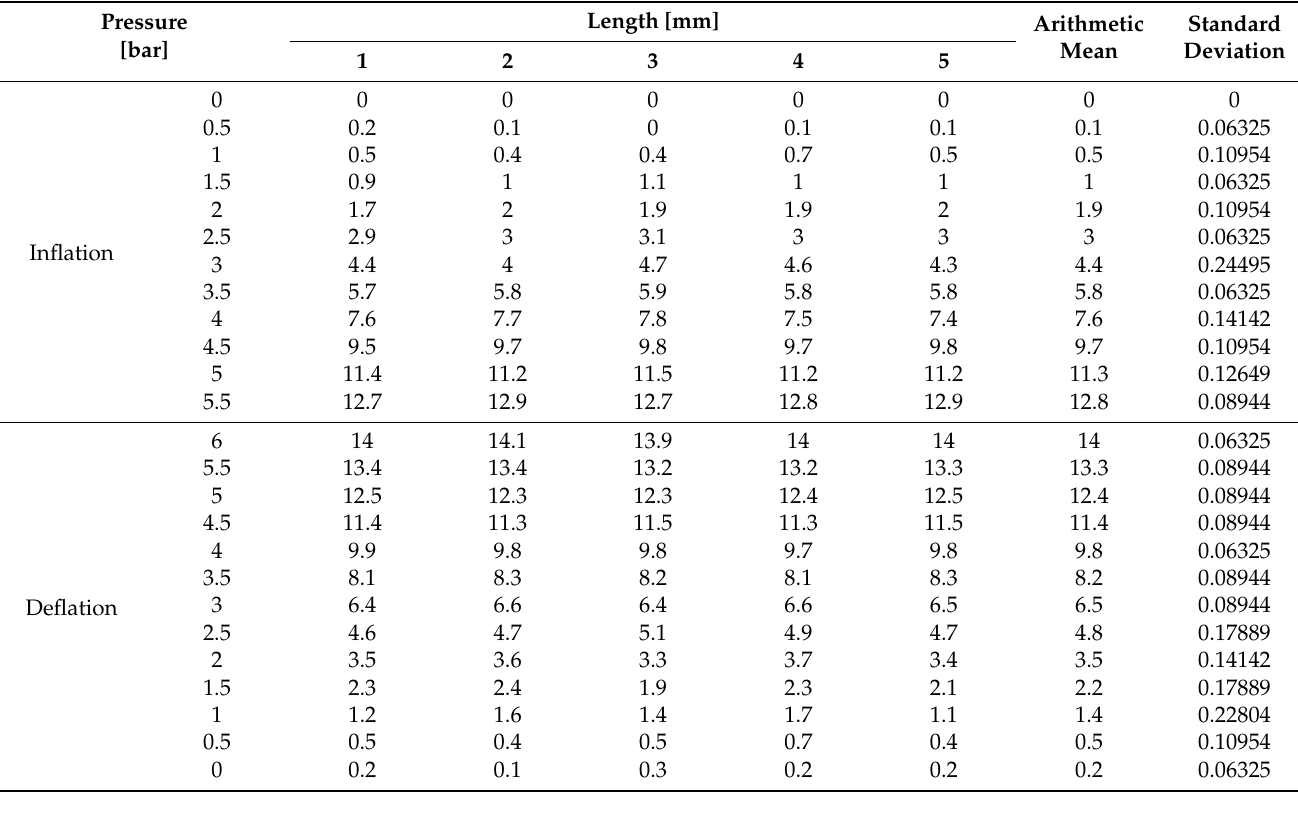
Table 5. Muscle axial contraction for a 4.55 kg external load.